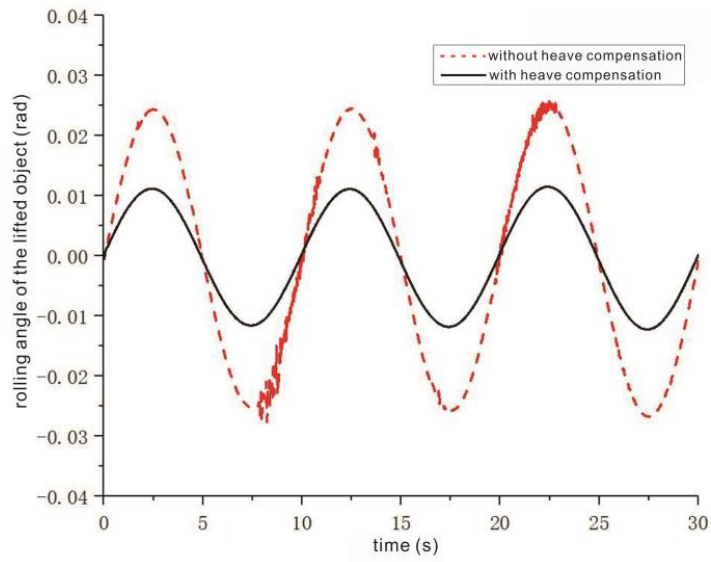
Figure 12. Rolling angle of the lifted object before and after compensation.